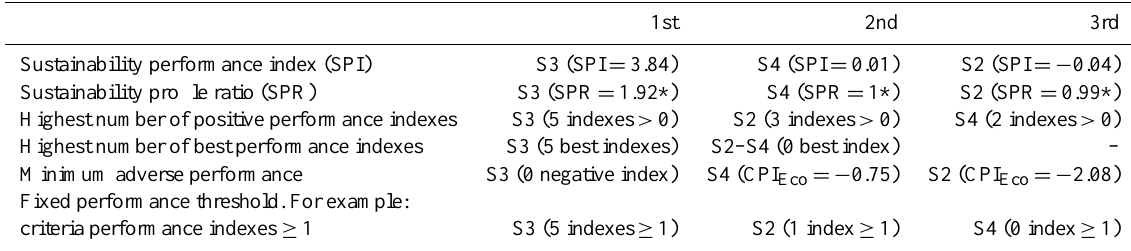
Table 8. Options ranking based on the decision rules (using a twenty-one-point scale).